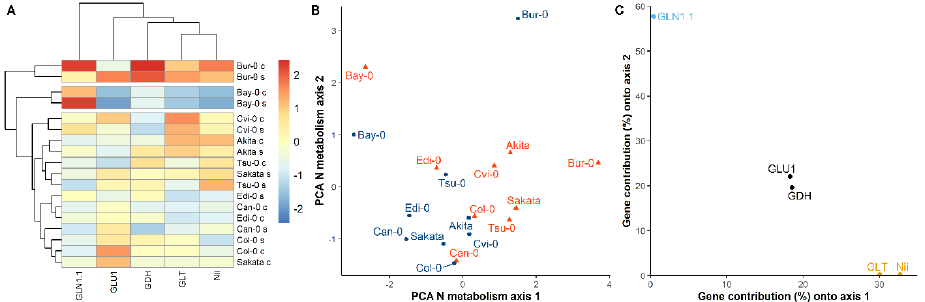
Figure 3. Classification of Arabidopsis accessions following their relative expression of N metabolism-related genes. ( A ) Heatmap of gene expression measured in nine accessions grown in the control or N starvation conditions. Red and blue represented relative high or low gene expression among genotypes. Genotypes were grouped based on the similarity of their expression. For each condition, the matrix of gene expression was centered and scaled over all accessions. ( B ) PCA analysis of expression of N metabolism-related genes. Blue dots and red triangles show the plants grown in the control and N starvation conditions, respectively. ( C ) Contribution of genes to the two first PCA components. The genes contributing above 4.5% to the first, second, or both components are respectively in orange, black, or blue.